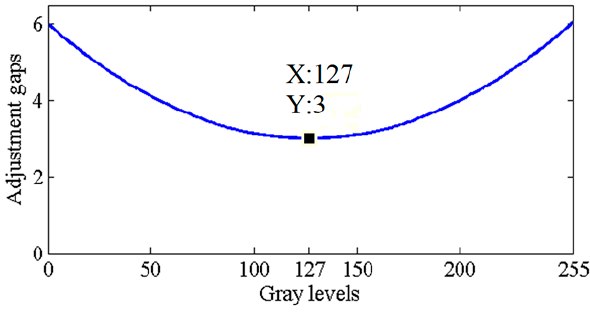
Figure 3. Gap Figure 3. Gap limiter.